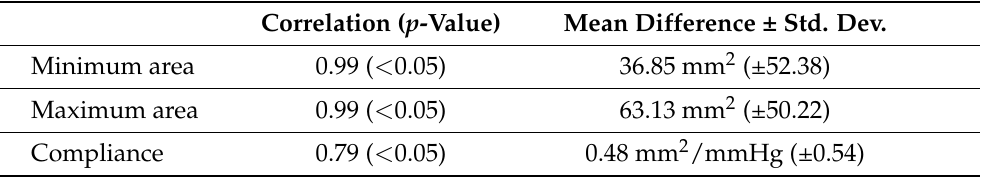
Figure 7. Example of automatic segmentation of the ascending aorta with our U-Net architecture. On the left, all the aortic surface is colored, in contrast to the right, where only the aortic wall is displayed. Table 3. Comparison between the ground truth and calculated values for minimal and maximal areas, and compliance. The aortic contours are extracted with the U-Net architecture and the dataset consists of 73 patients. The second column describes how similar are the results with the ground truth, and the p-values describe if the correlation results are significant. The third column describes the average difference (and corresponding standard deviation) between in-vivo and ex-vivo results, based on Bland-Altman plots [39].